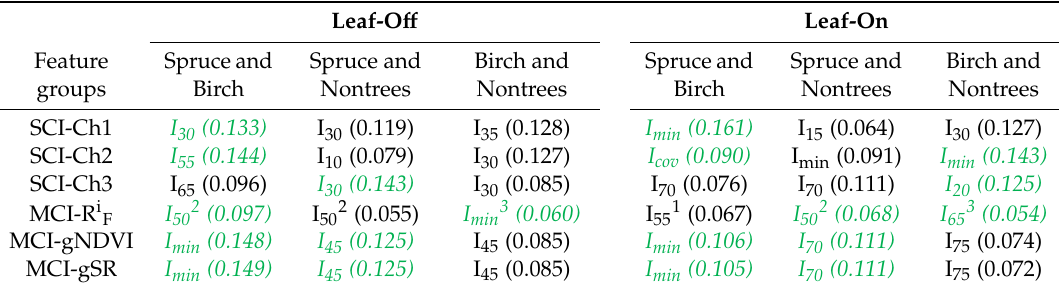
Table5. Themostimportantfeaturesselectedforclassificationinleaf-o ff andleaf-ondata. Green-colored features represent the most important and uncorrelated features. The descriptions of the features can be found in Table 4. The numbers in parentheses represent the feature importance